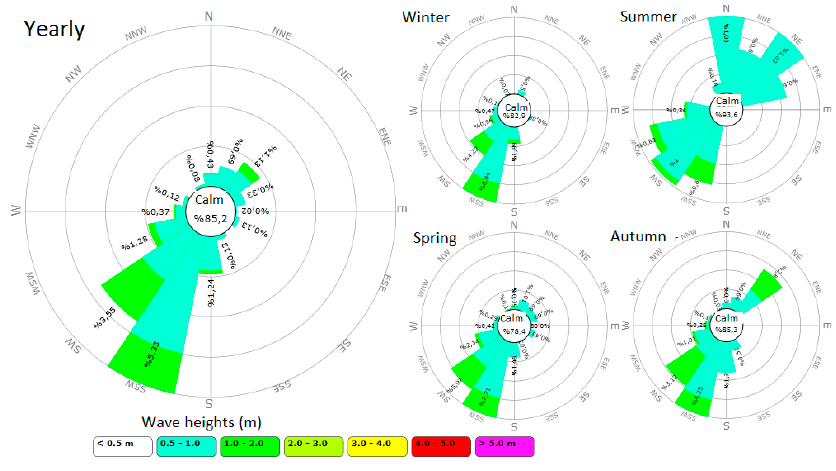
Figure 5. Wave roses [33].